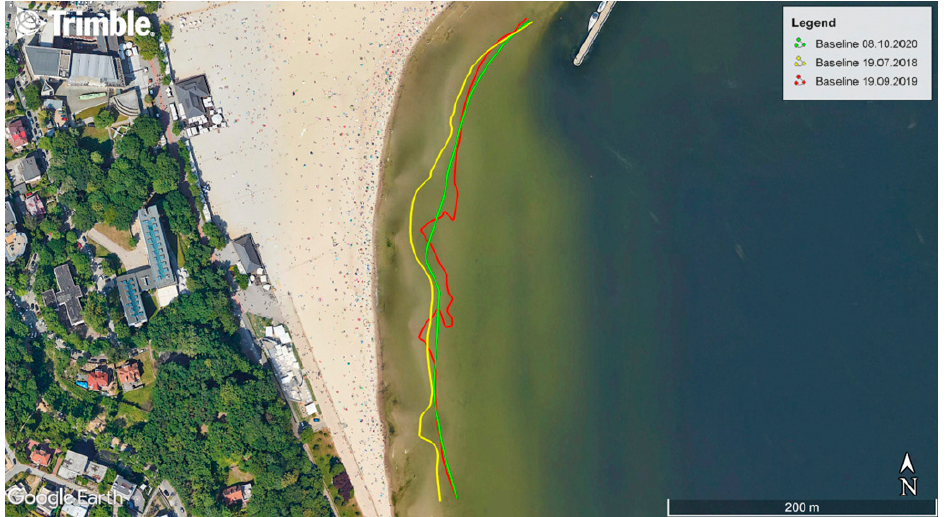
Figure 5. The course of the TSB of the waterbody adjacent to the public beach in Gdynia measured with the hydrographic method in 2018–2020.